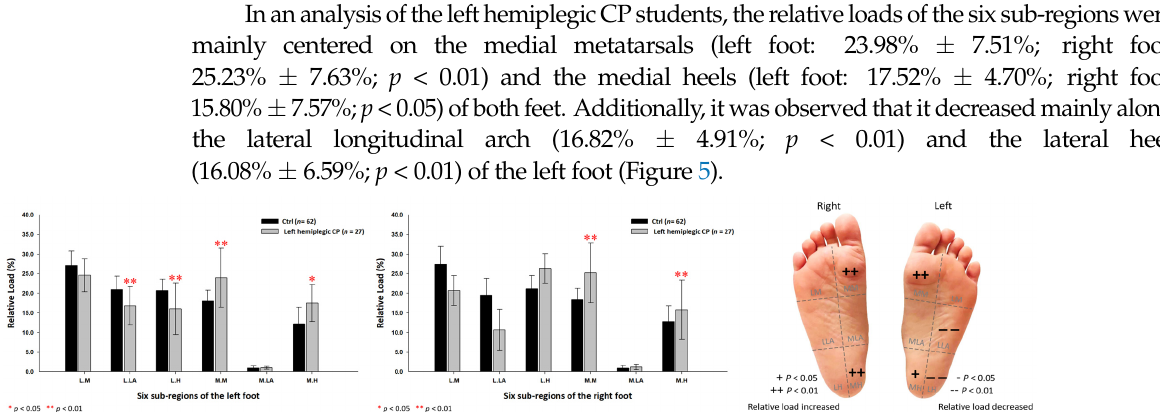
Figure 5. The percentage of six subregional relative loads of ( A ) left and ( B ) right feet in total students during static stance. The changes in pressure distribution are illustrated in ( C ) foot plantar diagram. Significant differences between the control group and the left hemiplegic CP group were determined as * p < 0.05 and ** p < 0.01. Further, in the male left hemiplegic CP group, the relative loads were primarily loaded on the medial metatarsals (left foot: 20.93% ± 9.34%; right foot: 26.95% ± 10.80%; p < 0.01) of both feet, the medial heel (20.19% ± 8.97%; p < 0.01) and the lateral heel (27.08% ± 5.53%; p < 0.05) of the right foot (Figure 6). As for the female left hemiplegic CP group, the loads were mainly directed toward the medial metatarsals (left foot: 26.42% ± 4.67%; right foot: 23.85% ± 3.43%; p < 0.05) of both feet, the medial longitudinal arch (0.99% ±